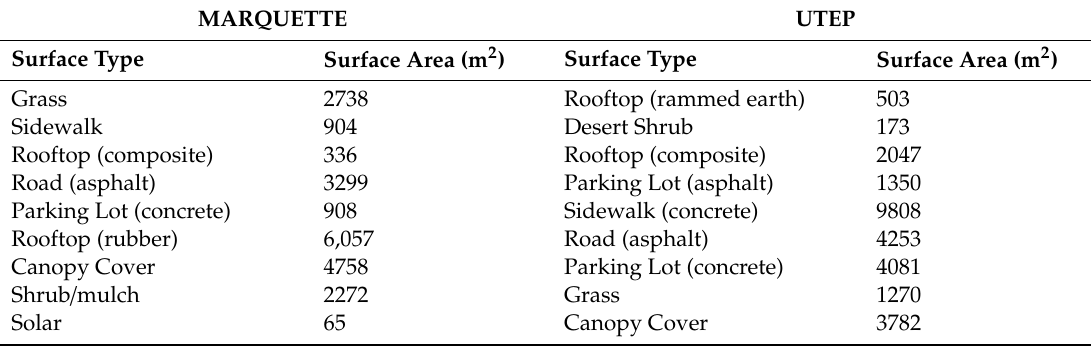
Figure 1. Visual imagery of the case study locations: Marquette University ( a ) and University of Texas El Paso (UTEP) ( b ). Visual imagery of Marquette was captured from a drone on 11 August 2018. Visual imagery of UTEP was pulled from Google Maps on 13 March 2019. Table 1. Surface types and surface areas within each case study location.